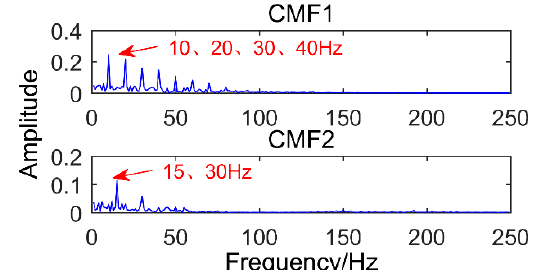
Figure 16. Envelope spectrum of recombination component.